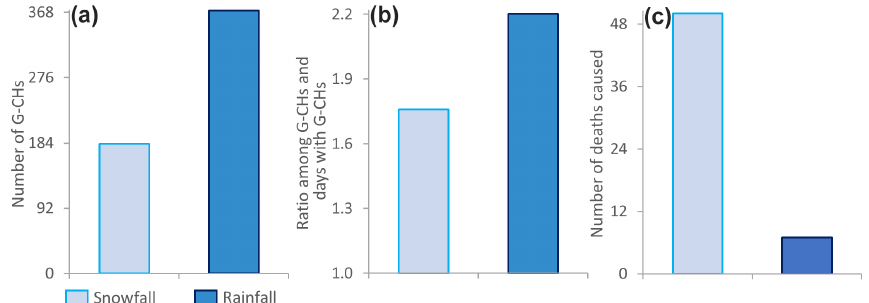
Figure 3. Main statistics of the G-CH triggers considering the entire record. (a) Total number, (b) relationship between number of G-CHs and number of days with G-CHs, and (c) associated